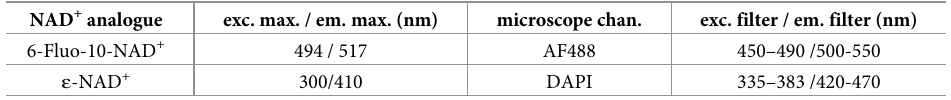
Table 1. Fluorescence of NAD + analogues and microscope filters. Excitation (exc.) and emission (em.) characteris- tics of the two fluorescent probes and of the microscope filter sets used to visualize them. NAD +